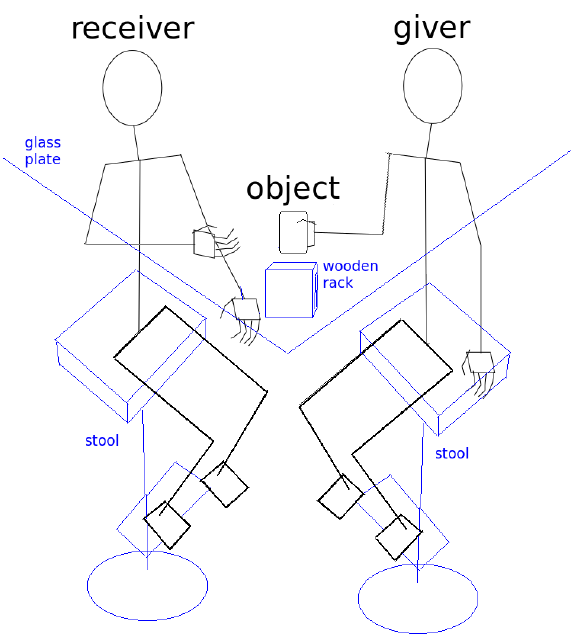
Figure 4. Sketch of the experimental setup, seen from the position of the